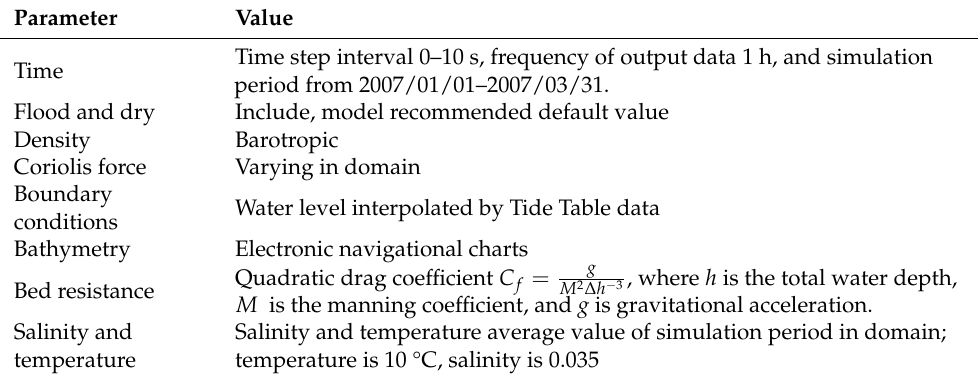
Table 2. MIKE21 Flow Model